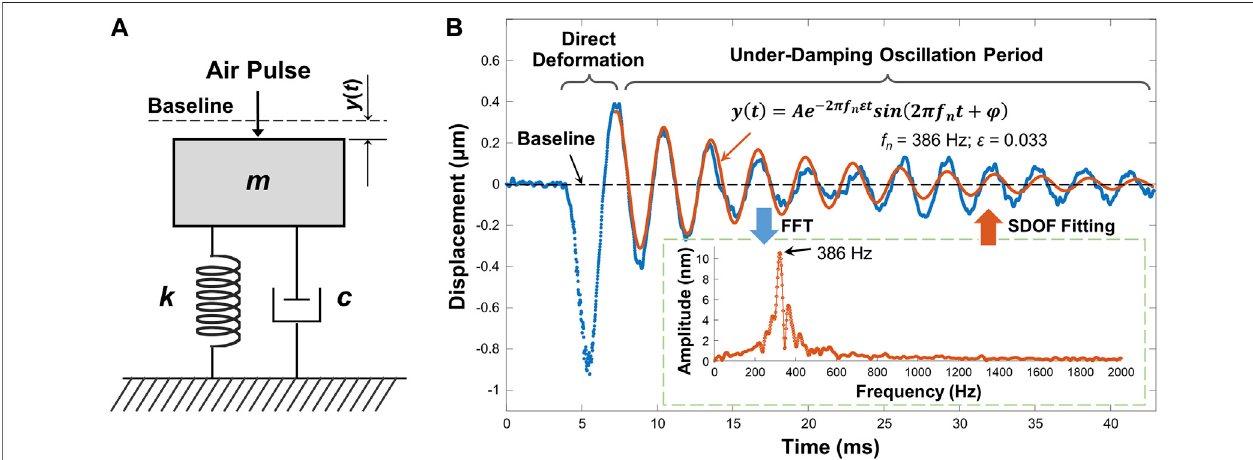
FIGURE2| Naturalfrequencycharacterizationusingsingledegreeoffreedom(SDOF)model. (A) Typicalspring-mass-dampersystem. m :mass; k :springstiffness coef fi cient; c : viscous damping coef fi cient; y ( t ): displacement dynamics. (B) Typical sample displacement pro fi le and the SDOF fi tting for its damping oscillation period (~7.2 – 42.9 ms). In this example, the sample was the agar phantom. The embedded fi gure shows the FFT results for the damping oscillation period. The dominant oscillation frequency was substituted into Eq. 3 to fi t the oscillation